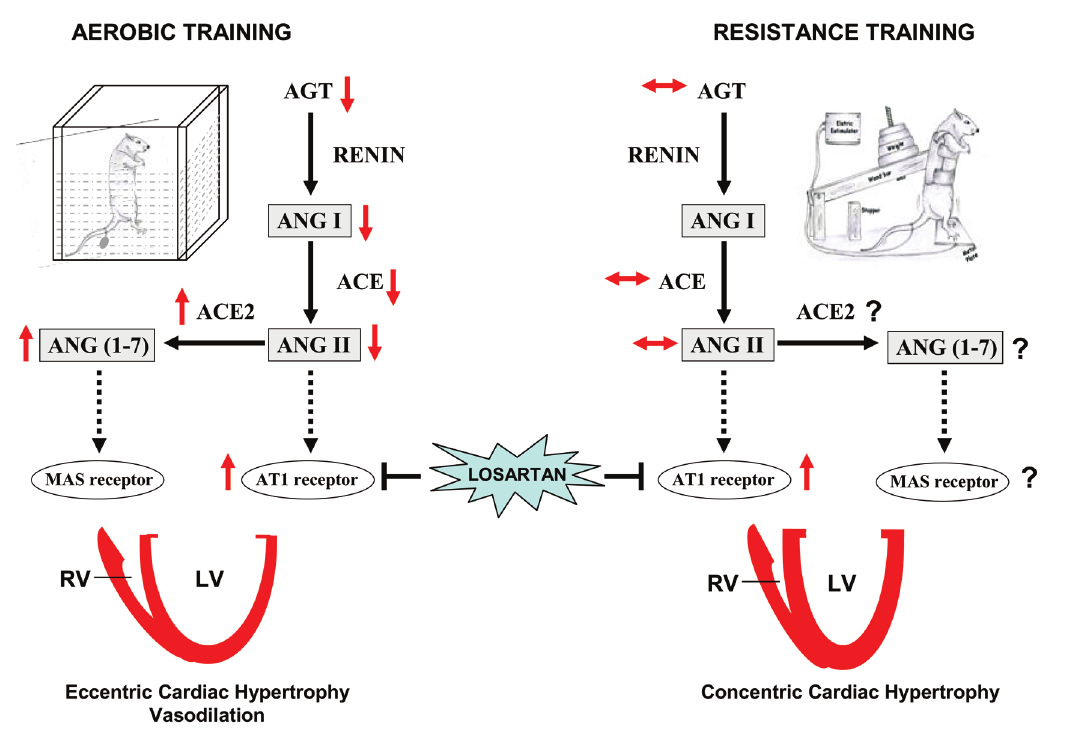
Figure 2. Schematic presentation of the effects of exercise training on the cardiac renin-angiotensin system (RAS). Aerobic and resistance training induced eccentric and concentric cardiac hypertrophy, respectively, via the angiotensin II type 1 (AT1) receptor, and both types of physiological cardiac hypertrophy were prevented by AT1 receptor blockade (Losartan). We suggest that aerobic training shifts the generation of angiotensin peptides away from angiotensin II (ANG II) and towards ANG (1-7), implicated in vasodilation and anti-fibrosis. In contrast, resistance training did not modify these cardiac RAS components. Red arrows indicate points of up-regulation, down-regulation or maintenance of RAS components induced by exercise training. ACE = angiotensin-converting enzyme; ACE2 = angiotensin-converting en- zyme 2; ANG (1-7) = angiotensin (1-7); AGT = angiotensinogen; RV = right ventricle; LV = left